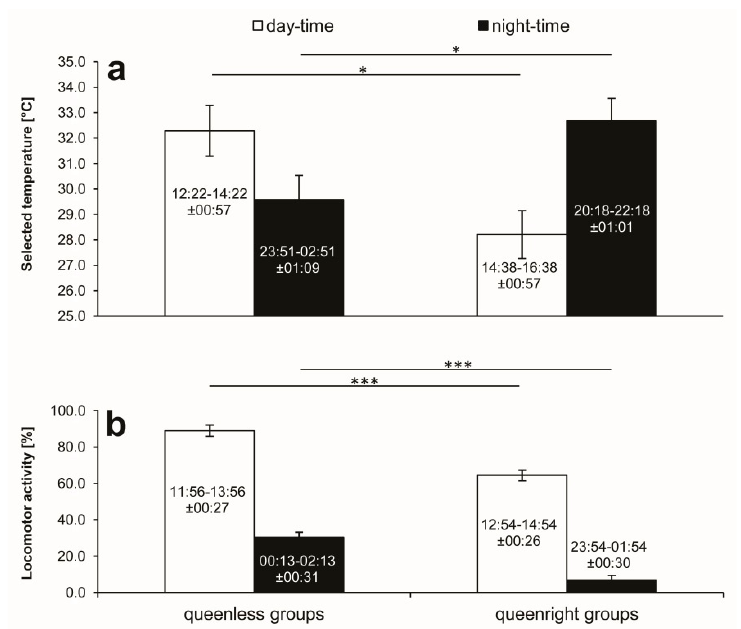
Figure 3. Average values ( ± SD) of two-hour periods of daily maximum and minimum selected ambient temperature ( a ) and locomotor activity ( b ), as well as the times (in hours and minutes) of their occurrence ( ± SD) in queenless and queenright groups of worker honeybees. Asterisks indicate the statistical significance of di ff erences between means: * p < 0.05, ** p < 0.01, *** p <